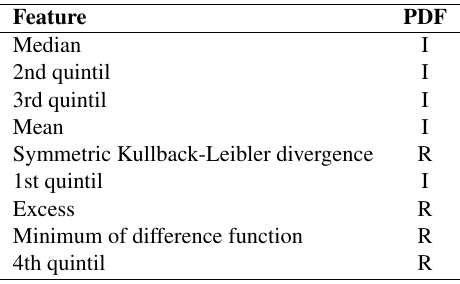
Table 3. Feature selection for the multi-class classification of dormer types (gabled, shed and both) based on simulated data.